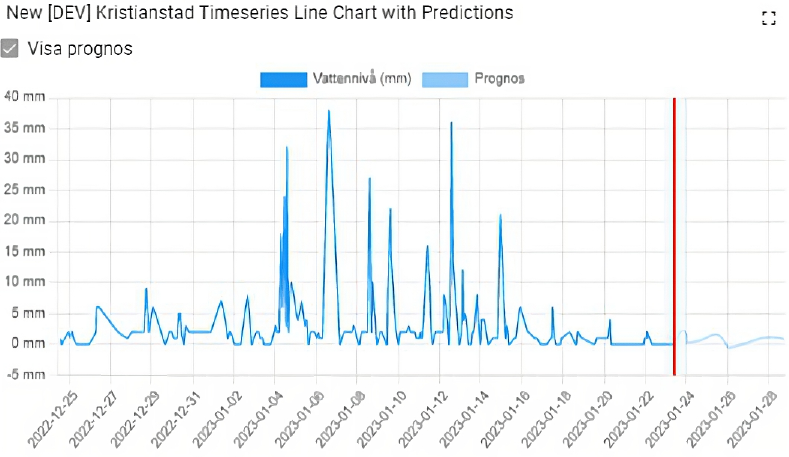
Figure 14. Real-time forcast data shown on IoT portal. Permission to publish is acquired from Kristianstad